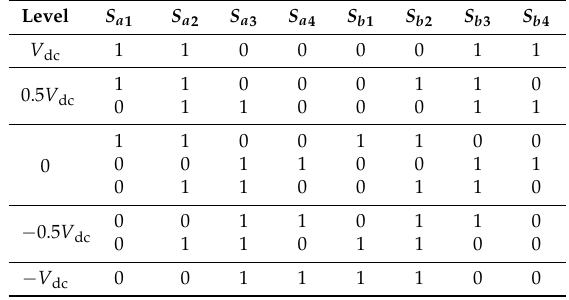
Table 1. Voltage level and switch mode.